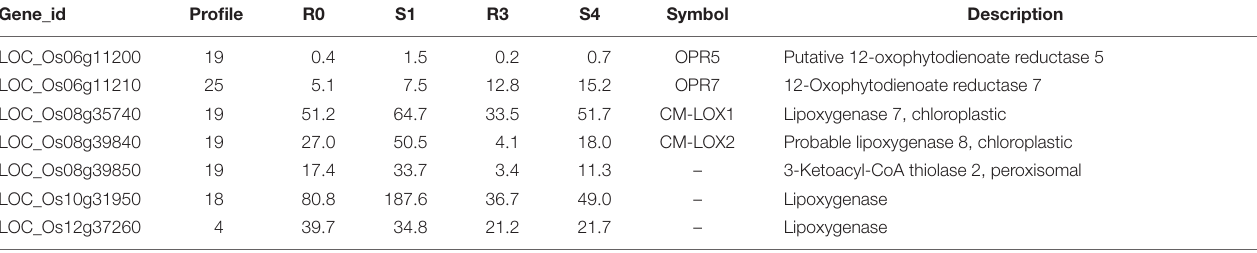
TABLE 2 | Three key lncRNAs and their associated mRNAs.